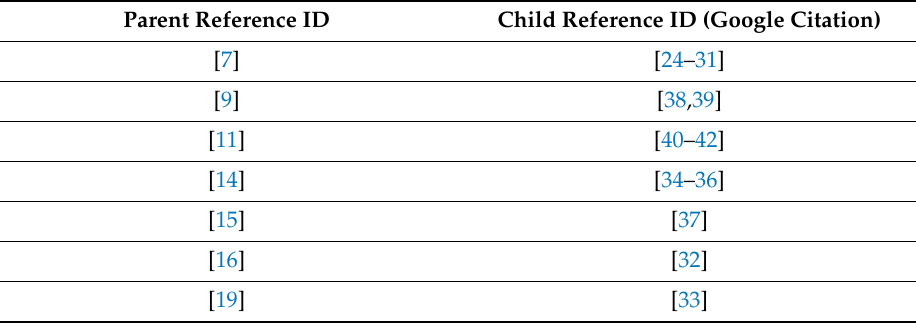
Table 4. Relation between Parent & Child studies.